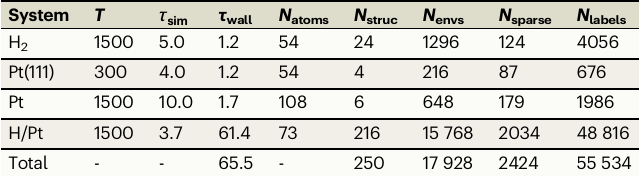
Table 1 | Summary of on-the- fl y training for the H/Pt system: the simulation temperature T (K); the total simulation time τ (ps); the total wall time of the simulation τ wall (h); the number of atoms in the simulation N atoms ; the total number of struc- tures added to the training set N struc ; the total number of local environments in all training structures N envs ; the total number of local environments added to the sparse set N sparse ; and the total number of training labels N labels System